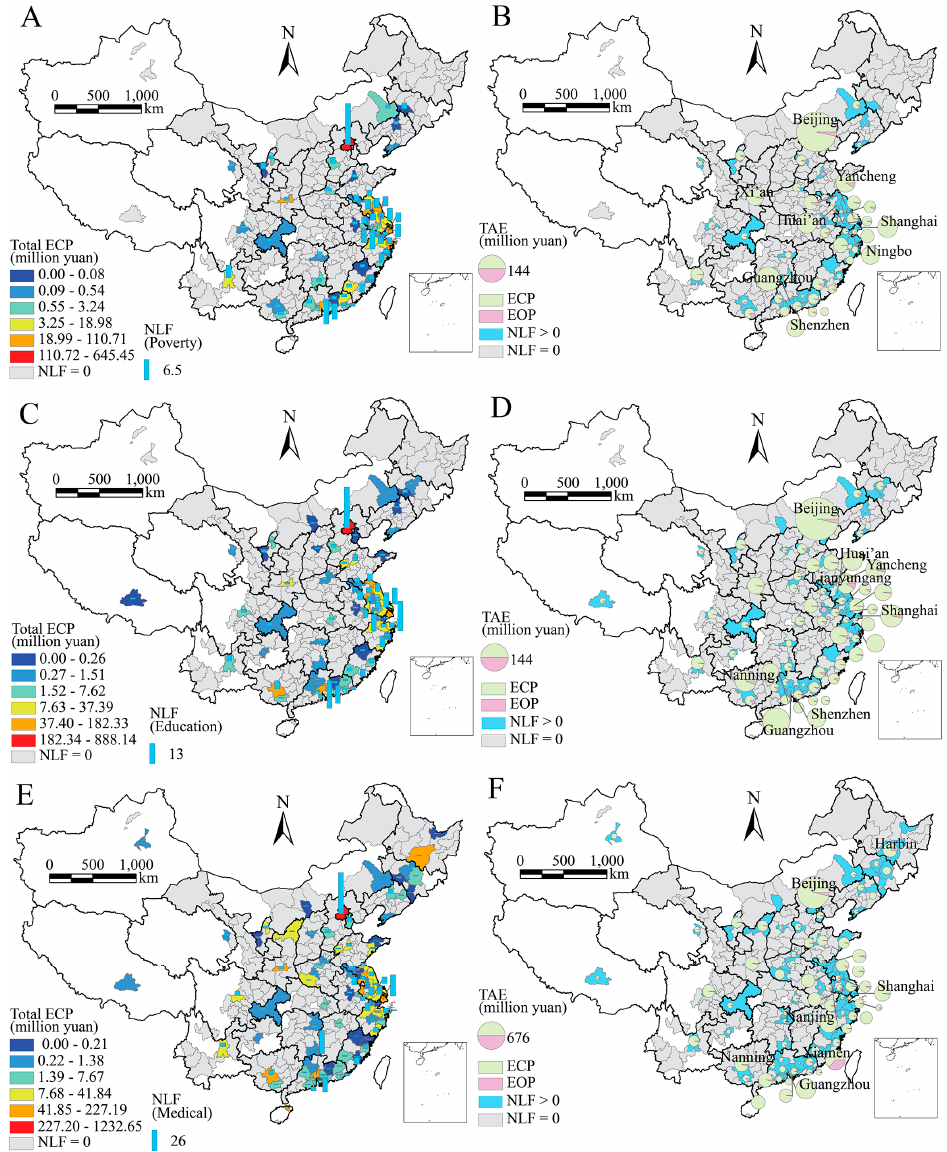
Figure 4. Distributions of provincial total charity expenditures ( A , C , E ) and their percentages ( B , D , F ) of local foundations in China.